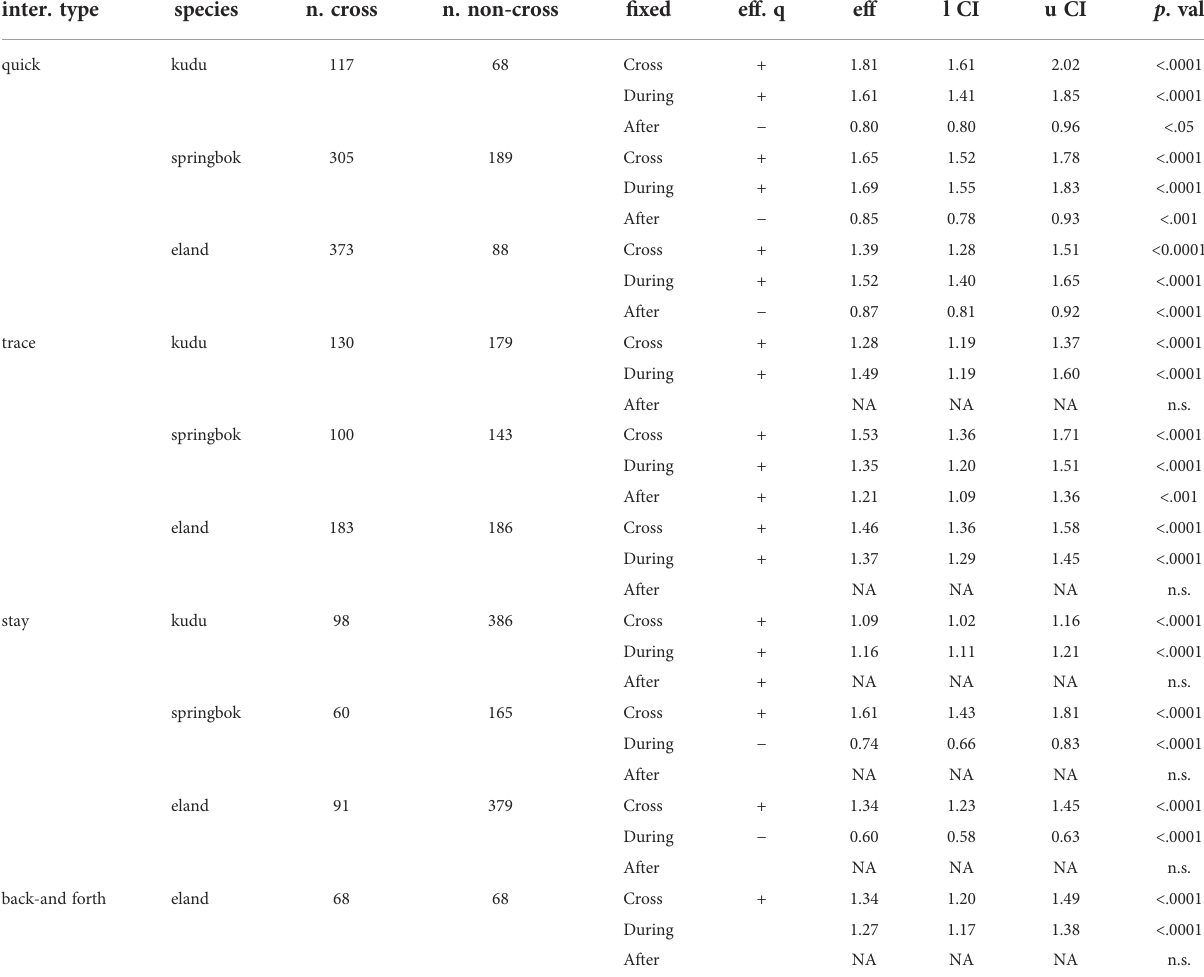
TABLE 3 Effect sizes of crossing fence interactions on movement speed. inter.